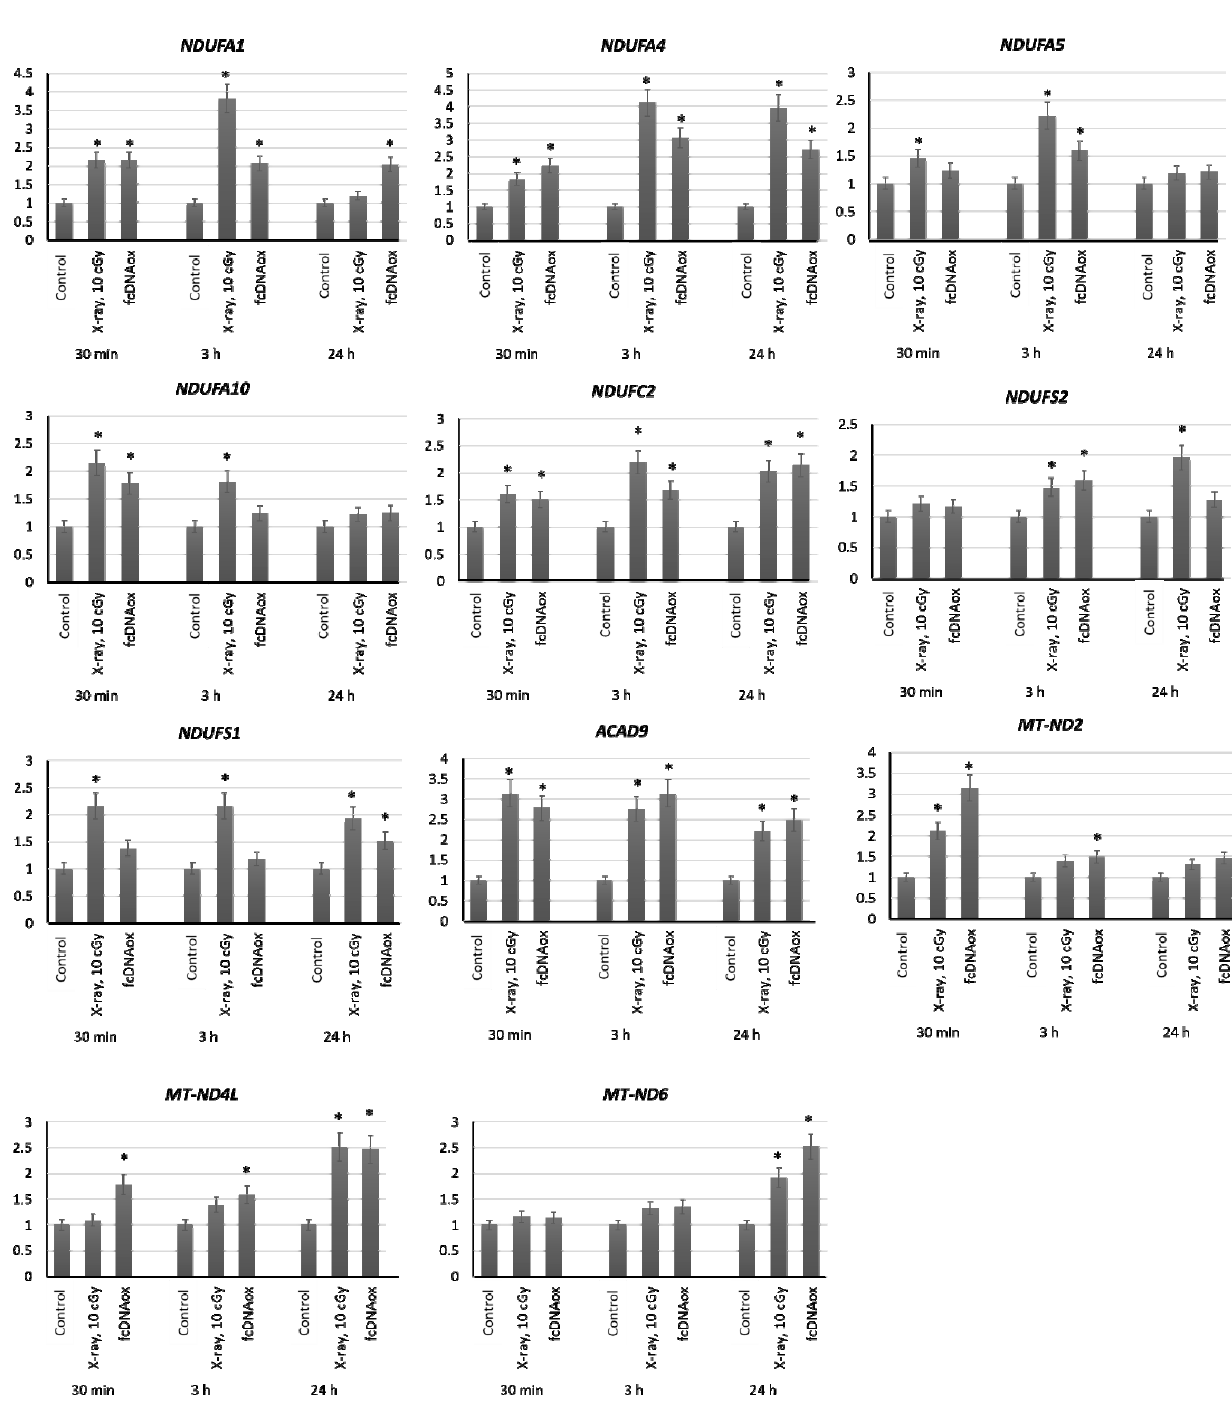
Figure 3. The expression of genes of the mitochondrial respiratory Complex I influenced by low-dose radiation (10 cGy) and oxidized cfDNA (50 ng/mL) assessed by real-time PCR. The genes are indicated in the figure. Ratios to control values are presented. The TBP gene was used as an internal standard gene. Mean values were calculated from five independent measurements; (*) denotes a significant difference from control experiments, p < 0.001, nonparametric U-test. The results demonstrate that both radiation at a dose of 10 cGy and cfDNAox causes an increase in the expression of nuclear DNA genes NDUFA1, NDUFA4, NDUFA5, NDUFA10, NDUFC2, NDUFS2, NDUFS1, and ACAD9 as well as mitochondrial DNA genes ND4L, ND2, and ND6 within 3 h after exposure. For several genes of the Complex I, the expression was increased for 24 (Figure 3).